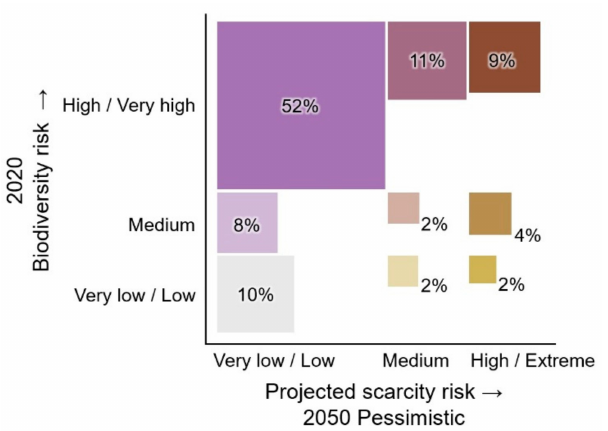
Figure 15. Biodiversity risk (using 2020 data for freshwater species richness) and projected risk of water scarcity under the pessimistic scenario for all dams in this study (existing and projected). The countries with the greatest number of dams in areas of medium to very high levels for both risks are Turkey (233 dams), Nepal (210), India (161), Spain (110),